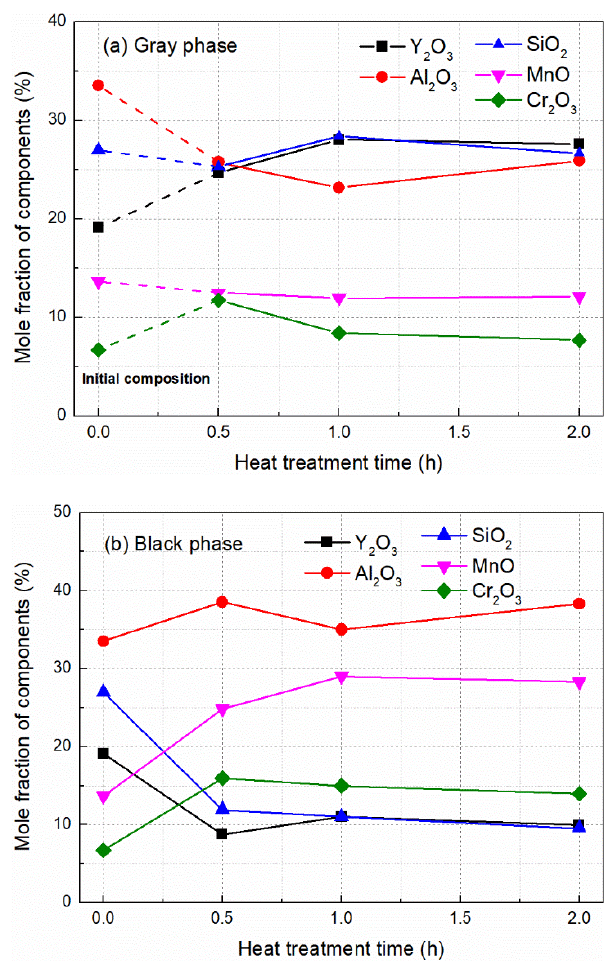
Figure 9. Change in composition of oxide inclusions in steel #1 during heating: gray phase ( a ) and black phase ( b ).